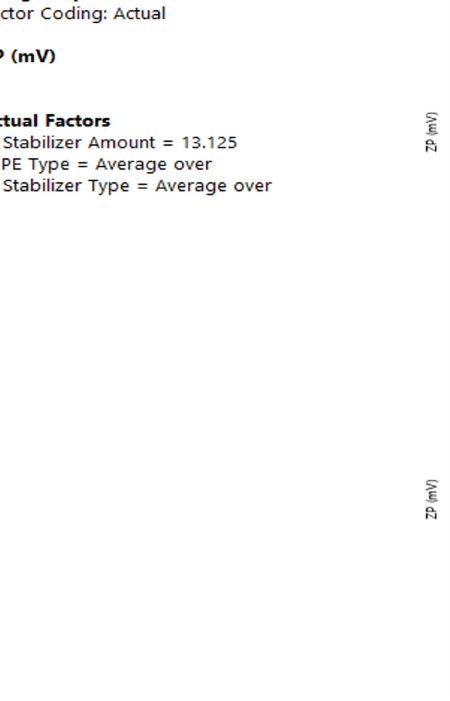
Table 3. Compositions, experimental and predicted data, and prediction error (%) of PS, PDI, and ZP responses of the optimized liquid crystalline nanostructures.